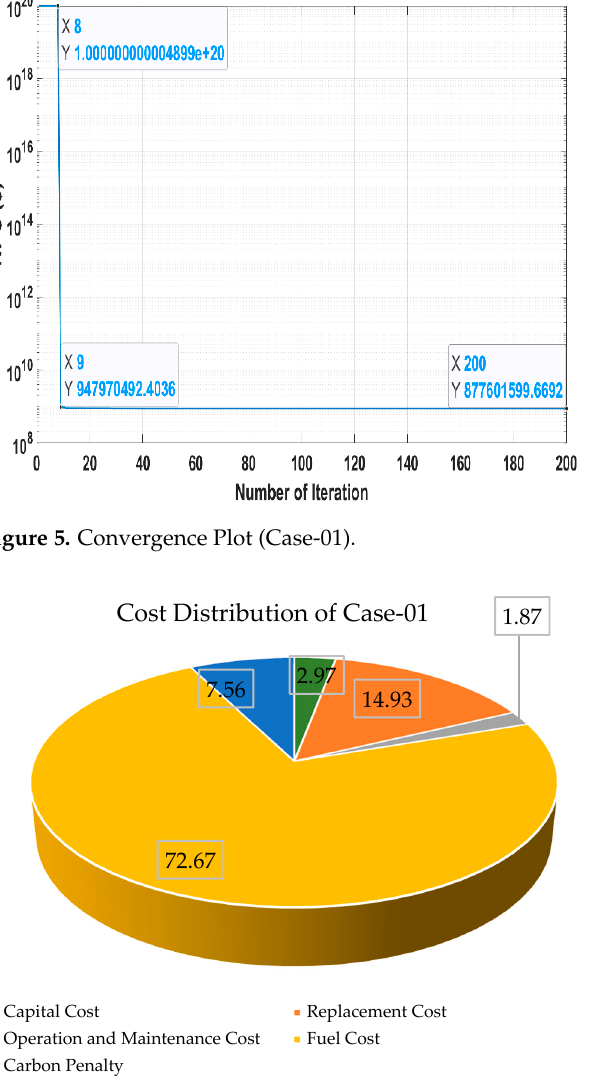
Figure 6. Cost Distribution (Case-01).